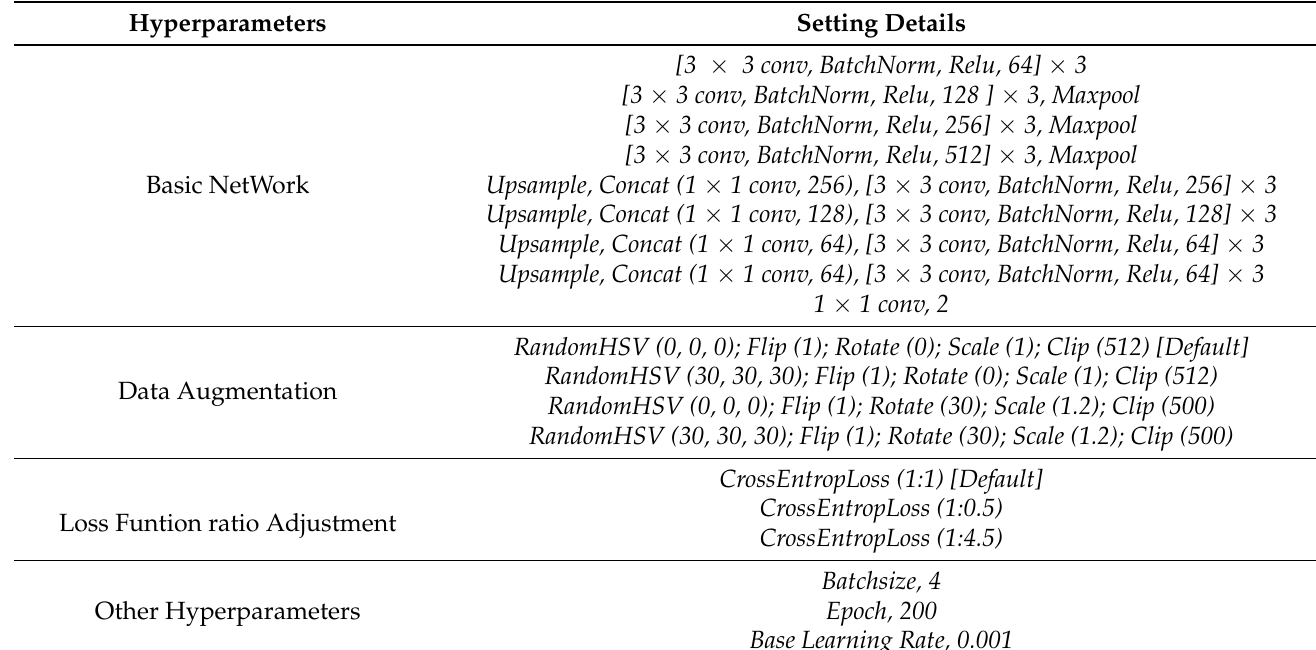
Table 3. Network parameter adjustment